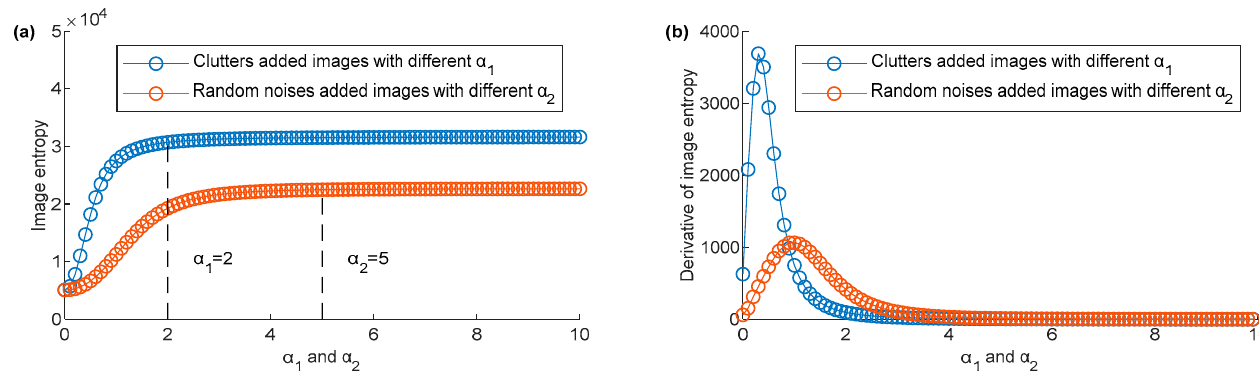
Figure 7. The image entropy analysis of α 1 and α 2 tests. ( a ) Images entropy of the radar profiles with different α 1 and α 2 . ( b ) The derivatives of the curves in ( a ).